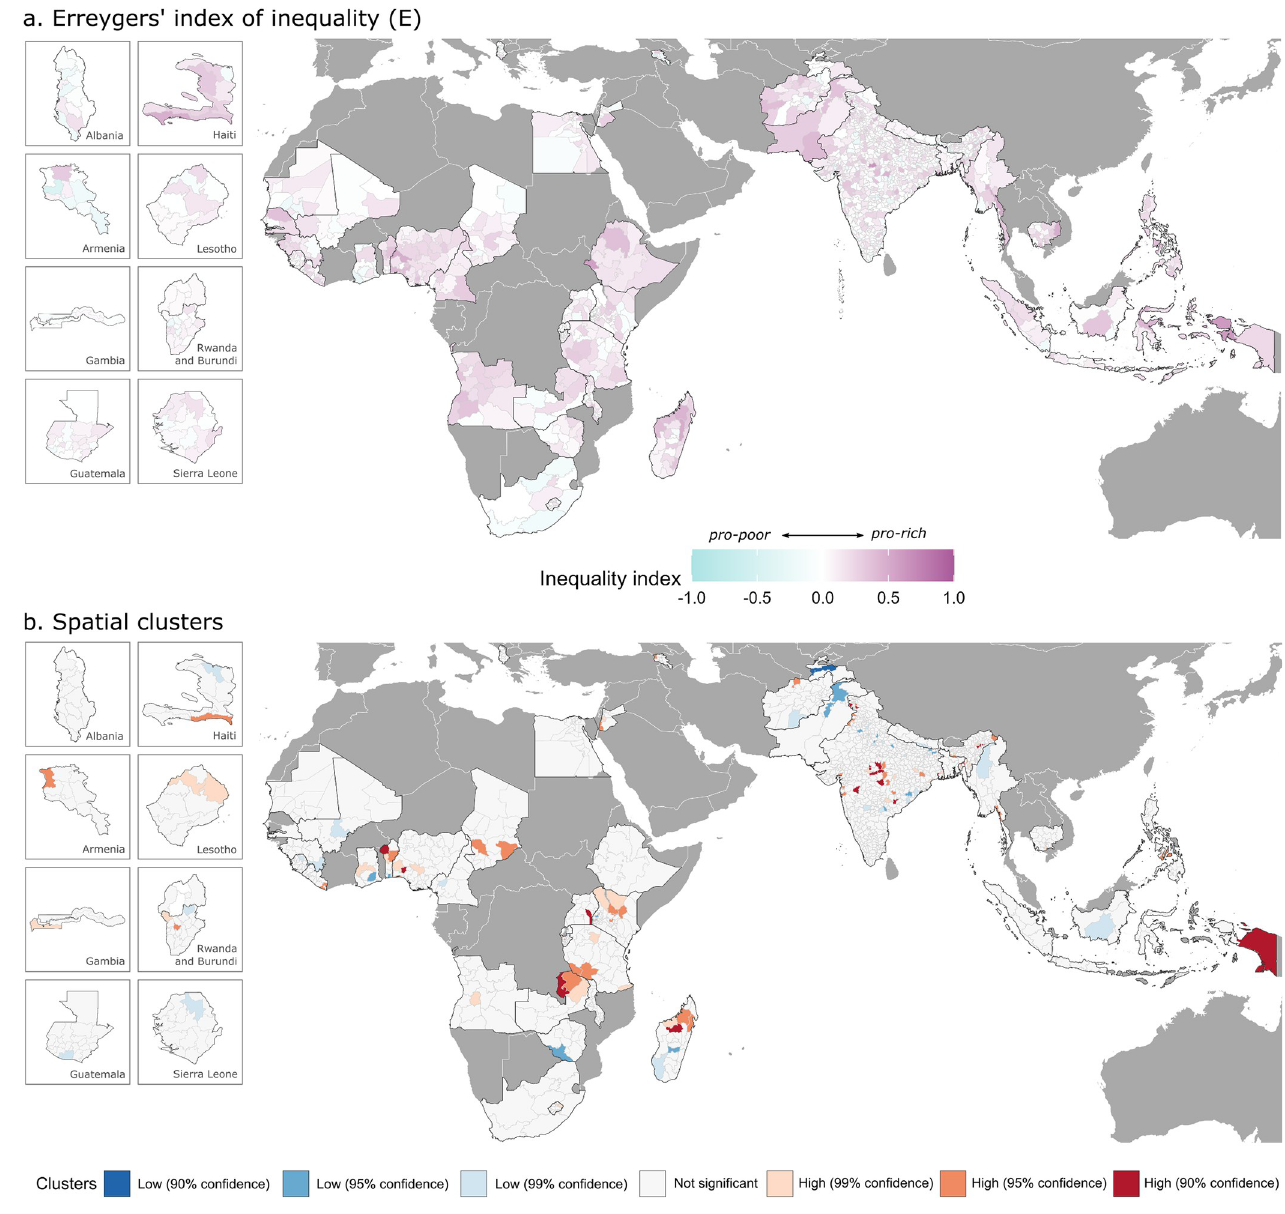
Fig 3. Subnational estimates of Erreygers’ index (E) of socioeconomic inequality (a) and spatial clusters of administrative regions with high (red colors) and low (blue colors) degrees of inequality (b). Spatial boundaries were retrieved from Natural Earth (https://www.naturalearthdata.com/) using the “rnaturalearth” package (https://github.com/ropenscilabs/rnaturalearth).